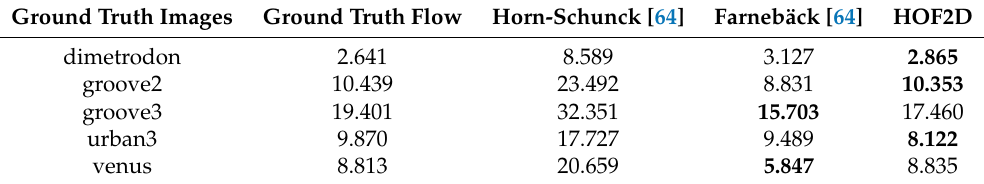
Table 2. Interpolation Error Calculation.